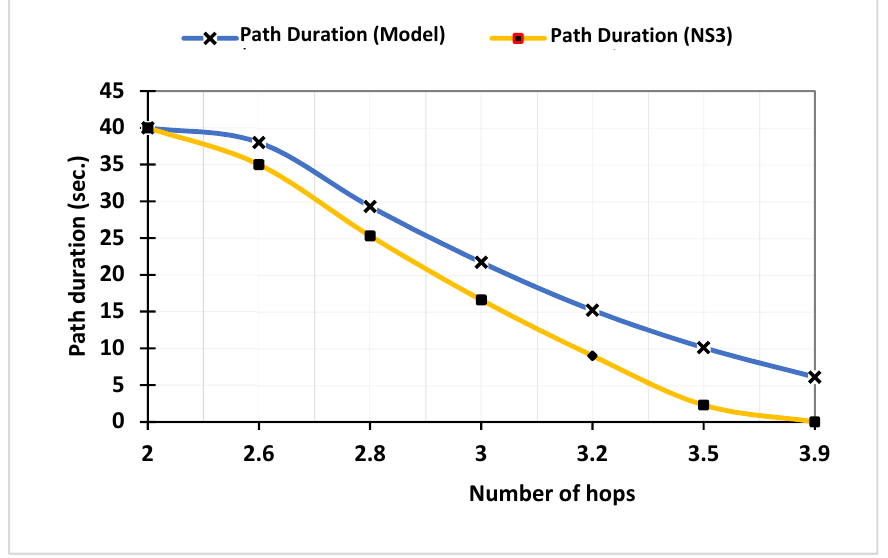
Figure 11. DSDV path duration vs. number of hops.